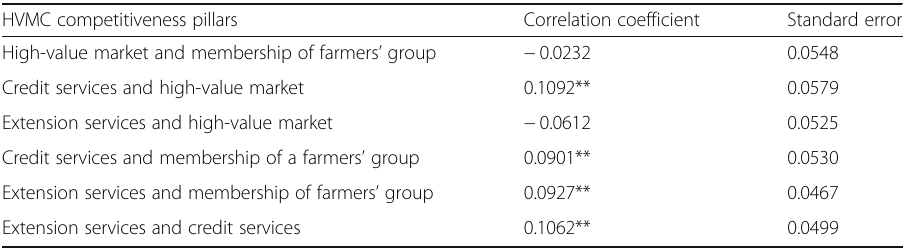
Table 2 Correlation coefficients of pillars of competitiveness in HVMC from MVP estimation HVMC competitiveness